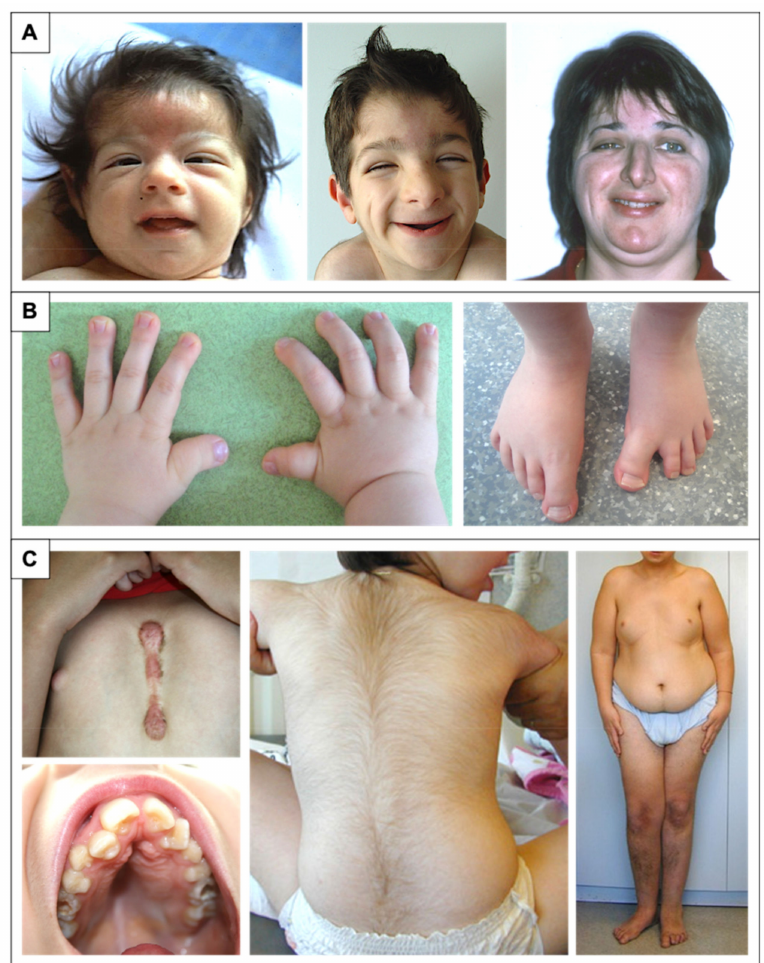
Figure 1. Physical features in RSTS patients. ( A ) Evolution of the phenotype from birth to adulthood. The glabellar hemangioma classically disappears during childhood. The palpebral slits are more oriented downward and outward. Nasal features are more obvious with a prominent nose and a protruding columella. The characteristic grimacing smile with closure of the palpebral fissures and bilateral and asymmetric ptosis of the eyelids can also be noted. The patient on the left was previously reported at 2 months of age by Lacombe et al. [81]. The patients in the middle and on the right have not been reported in any publication to date and were 4 and 33 years old, respectively, at the time of description. ( B ) Distal limb abnormalities with broad thumbs and halluces. Characteristic aspect of short, broad hands with broad thumbs with radial deviation and spatulate last phalanges; enlarged halluces are a near-constant sign. ( C ) Additional classic features in RSTS. We can note the formation of a keloid scar post-sternotomy for cardiac surgery; the highly arched palate with the presence of talon cusps of the four upper incisors and the dental caries of the premolars; the hypertrichosis and the risk of being overweight or obese during